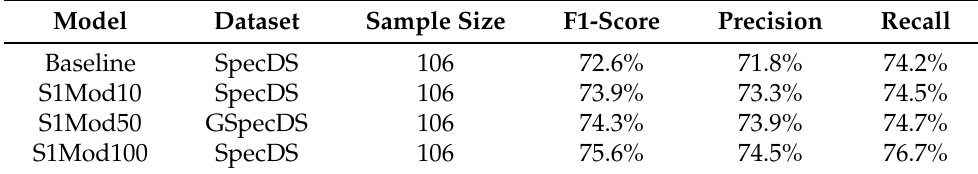
Table 4. Evaluation results.